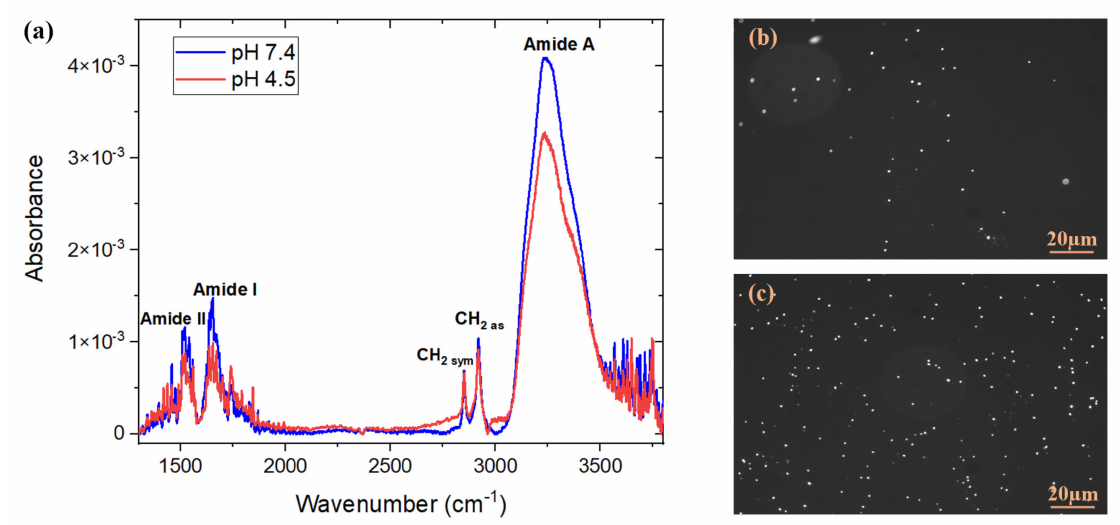
Figure 5. ( a ) FTIR absorbance spectra of E. coli antibodies immobilized on MHDA/MUDO (1:9) SAM-coated GaAs samples following 1-h exposure to 100 µ g/mL antibody suspensions at two different pH conditions. Each spectrum represents an example of one of 3 tested samples; fluorescence images of GFP E. coli bacteria immunocaptured after 1-h exposure to E. coli suspensions at 10 6 CFU/mL. The E. coli antibodies were immobilized following 1-h incubation in suspensions at 100 µ g/mL in two different buffers: ( b ) acetate (pH 4.5) and ( c ) PBS (pH